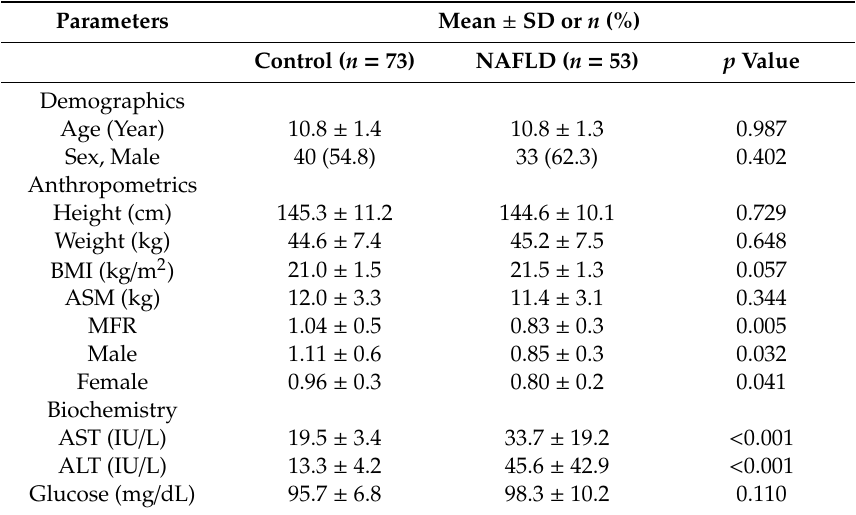
Table 1. Comparison of baseline characteristics between the control and NAFLD group.